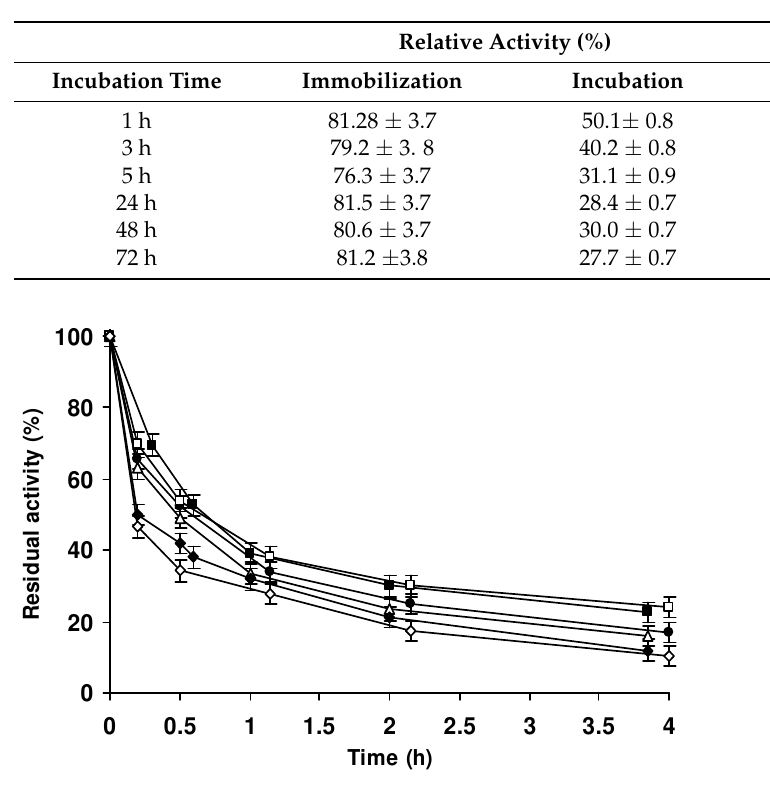
Figure 6. Effect of the incubation time on the stability of PGA biocatalysts immobilized at pH 7 and incubated at pH 10.0 during different times (see Table 4 for more details). Empty triangles with solid line: 1 h. Full circles with solid line: 3 h. Full squares with solid line: 5 h. Empty squares with solid line: 24 h. Full rhombi with solid line: 48 h. Empty rhombi with solid line: 72 h. Other specifications are described in the Methods Section.